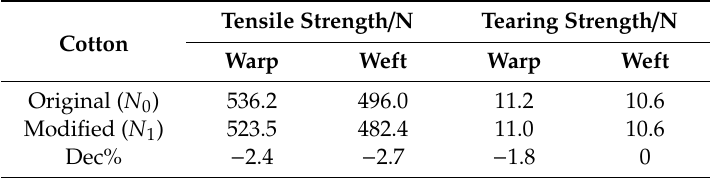
Table 3. Mechanical strength of the original and DMC-modified cotton Tensile Strength / N Tearing Strength / N Cotton Warp Weft Warp Weft